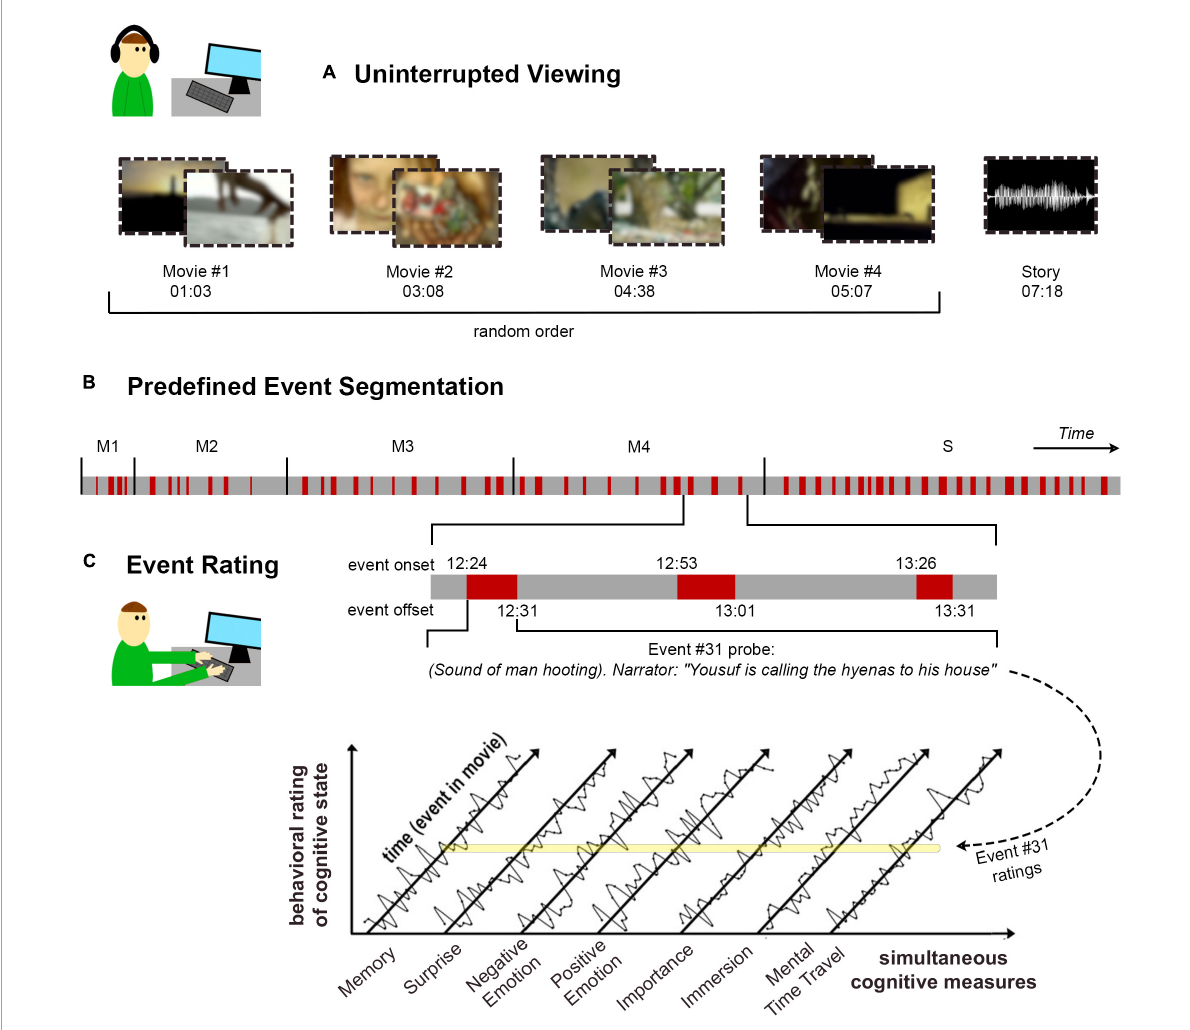
FIGURE1 Experimental approach. (A) In the first part of the task, participants viewed four short movies (in random order) and listened to a story, sequentially with no interruptions. The duration of each stimulus is detailed as min:s. The stimuli were streamed online to participants’ personal devices. (B) Prior the experiment, textual descriptions were generated to match a total of 55 stimulus events, with four events in Movie #1 (M1), seven in Movie #2 (M2), 11 for each of Movies #3 (M3) and #4 (M4), and 22 events for the story (S). Event onset and offset (as min:s) match the beginning and end of the happenings described in the textual event reminder. (C) In the second part of the task, participants filled out the retrospective behavioral sampling (RBS) questionnaire, in which they viewed the textual reminder for each event (in random order within each stimulus block) and rated their experience of it on an array of cognitive dimensions. Time-courses represent hypothetical rating data. The yellow line illustrates where the example Event #31 falls within each of the rating